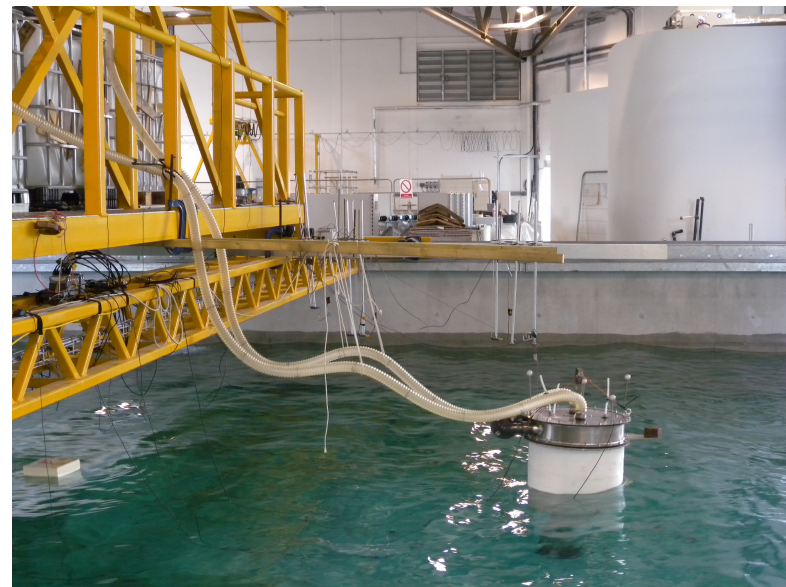
Figure 12. Physical model of the Tupperwave device.